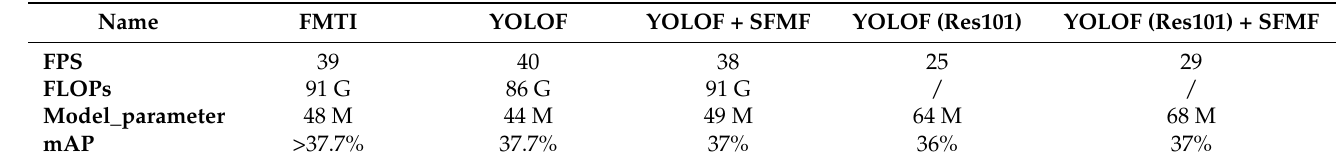
Table 4. Preliminary comparison results of different